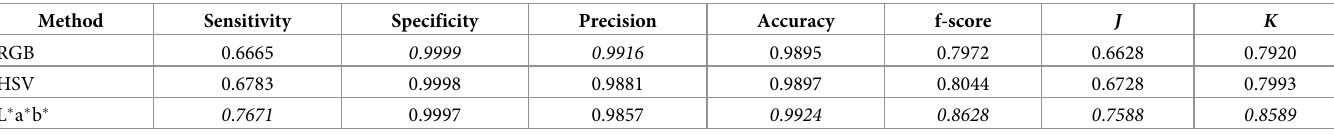
Table 2. Results obtained by comparing the resulting images with the ground truth.